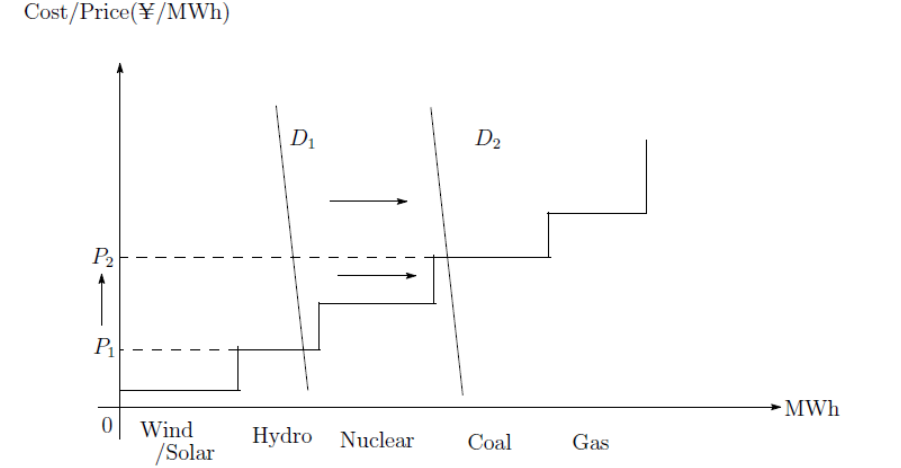
Figure 3. The Price Effect of Increasing Demand.